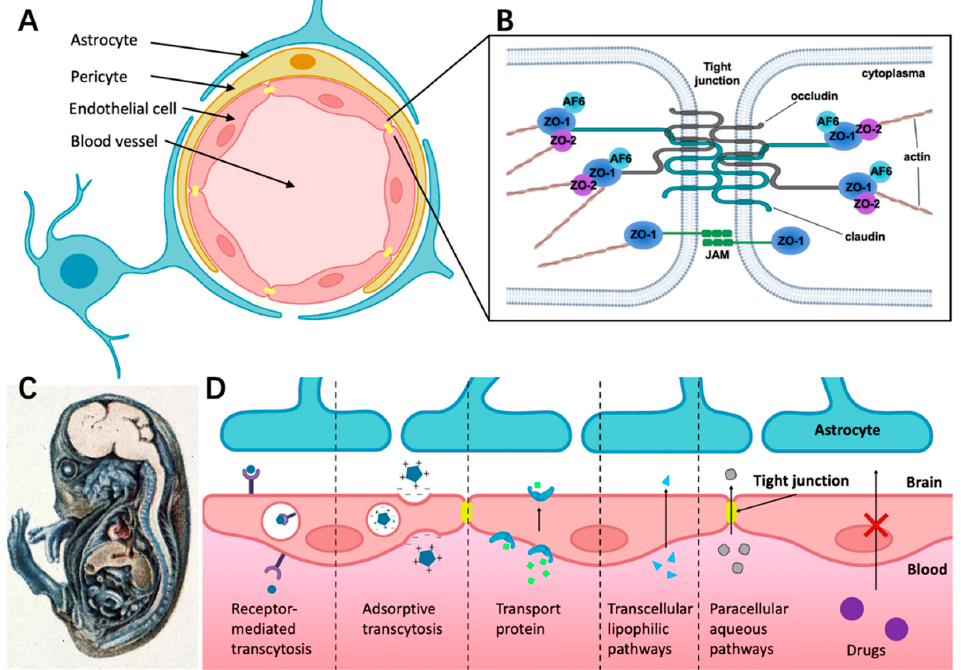
Figure 1. The structure of BBB and different transport pathways for substances across the BBB. ( A ) The BBB consists of endothelial cells (ECs) surrounded by pericyte and astrocyte endfeet. ( B )